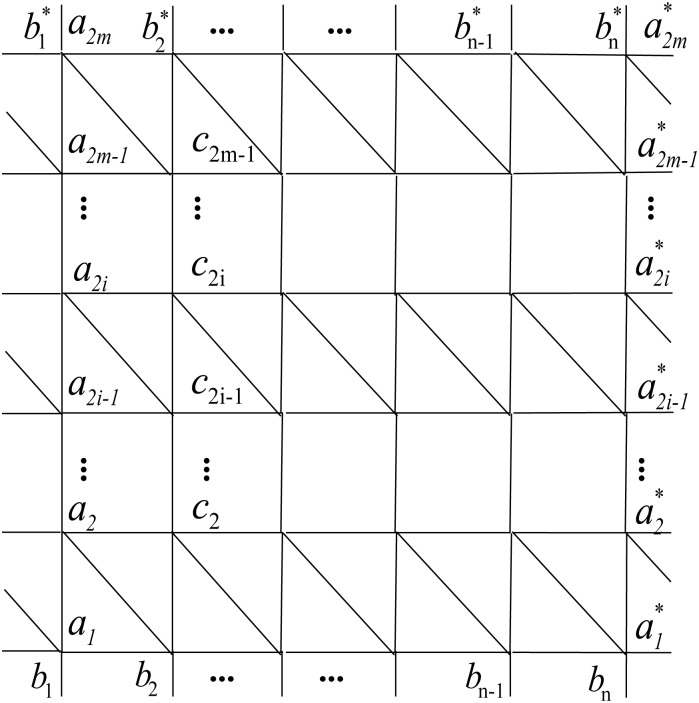
The 33 ⋅ 42 lattice.